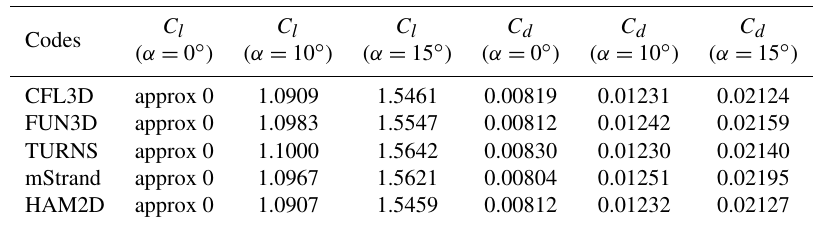
Table 1. Comparison of lift and drag coefficient for the NACA0012 airfoil using the SA turbulence model against other implementations in NASA-TMR (TMR,